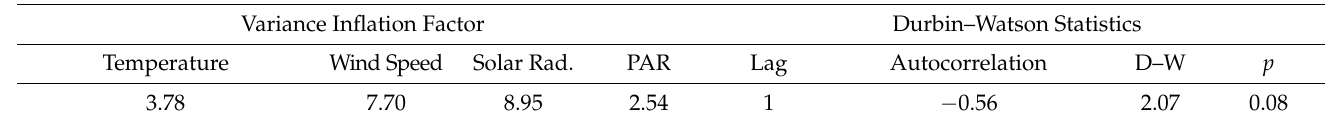
Table 8. Prior to the analysis of the results, Durbin–Watson statistics were performed to verify